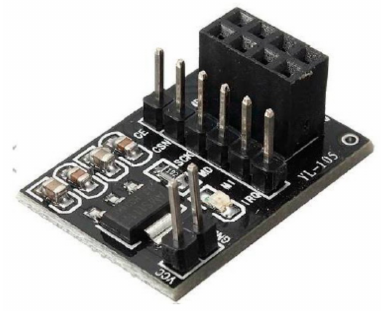
Figure 5. NRF Adapter